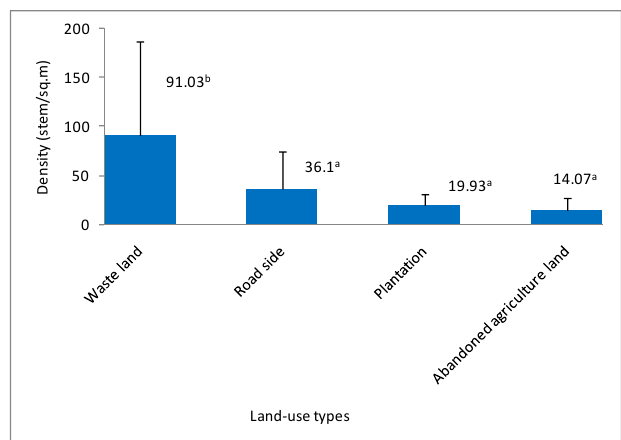
Fig. 3: Spatial distribution of Parthenium in Kirtipur Municipality